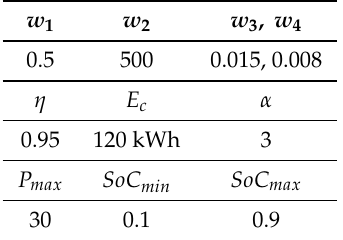
Table 3. Parameters for ESS scheduling.